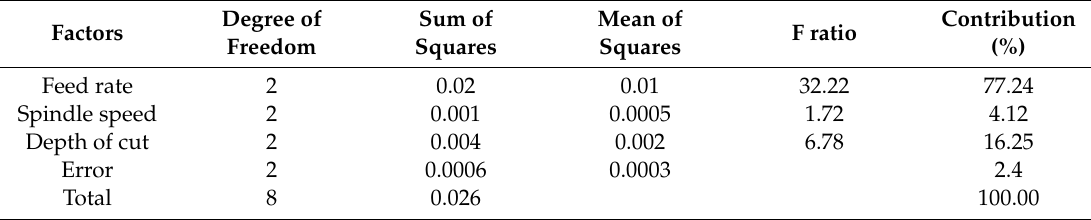
Table 8. Analysis of variance for the surface roughness.